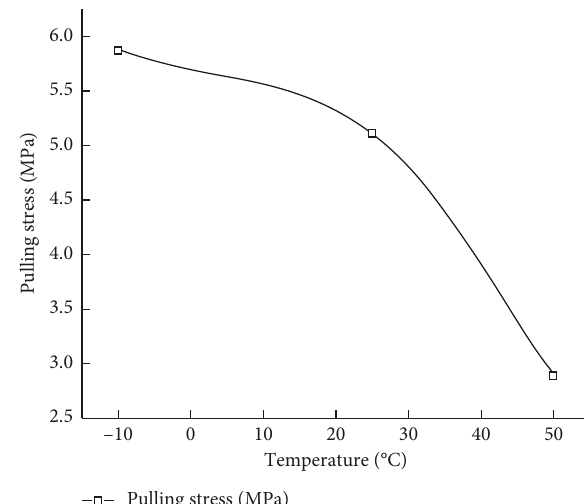
Figure 7: Pull-out test at different environmental temperatures. All interface destructions of specimens were 100% concrete failure.